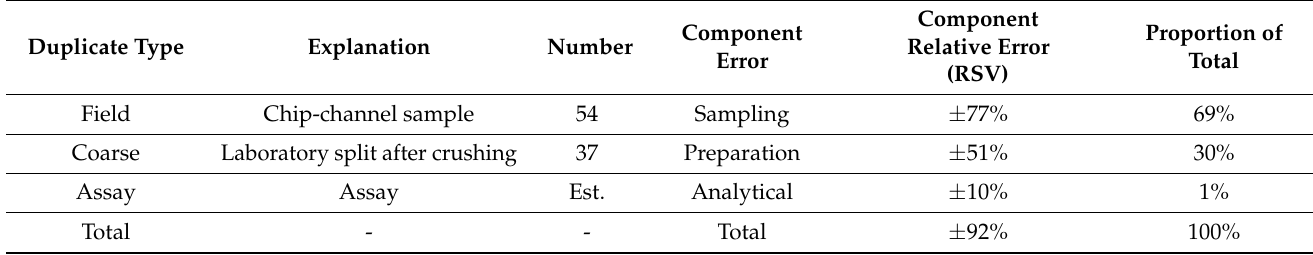
Table 20. Duplicate evaluation of LV chip-channel samples.